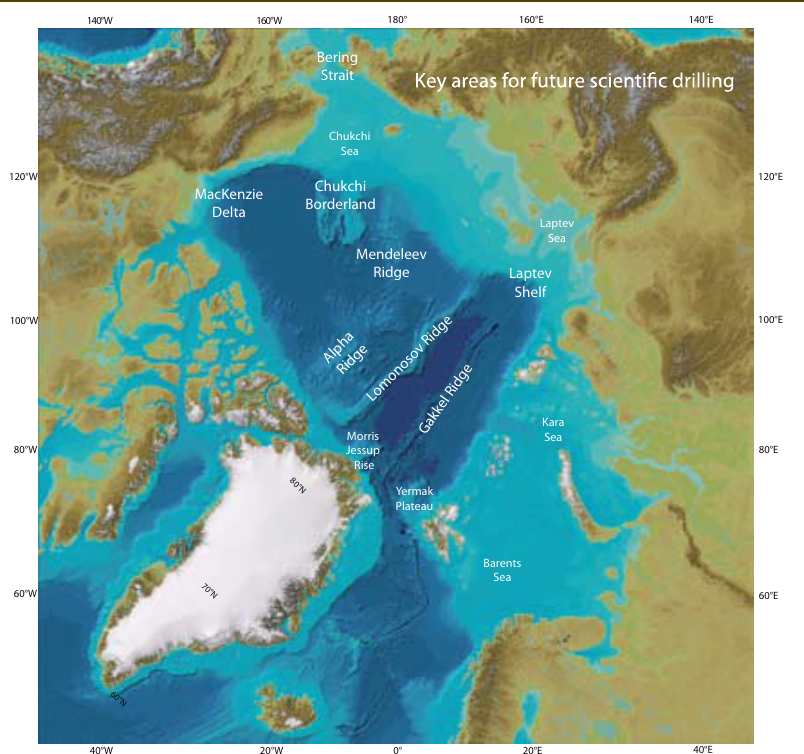
Figure 1. The proposed drilling regions for the Arctic are primarily ridge tops, which will have condensed sections, making it possible to sample relatively long intervals without deep penetration of the seabed. There is also a desire for expanded, high resolution, sections, which can be recovered from the continental shelves. (Background map is from IBCAO, Jakobsson et al.,